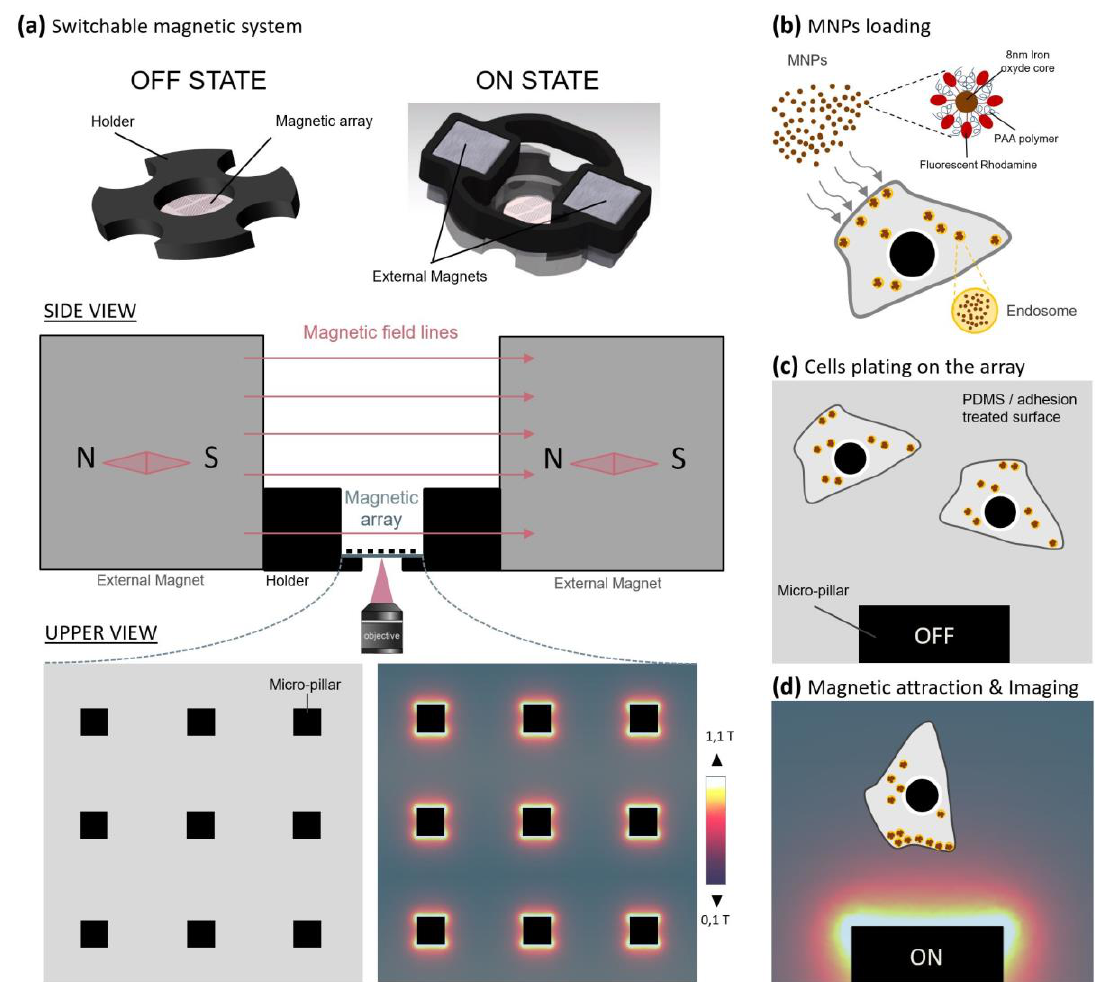
Figure 1. Parallelized magnetic manipulation on a micro-magnetic array. The micro-magnetic array consists of a matrix of 100-µm-wide soft ferromagnetic pillars. The micro-pillars can be magnetized using a homogeneous external magnetic field (ON State) or demagnetized when the field is removed (OFF State). Magnetized micro-pillars generate a high magnetic gradient up to 10 4 T/m ( a ). The micro-magnetic array was made biocompatible by coating the surface with thin PDMS layer and an adhesion molecule coating. To perform the magnetic manipulation experiment, cells were first loaded with magnetic nanoparticles (MNPs) during 18–24 h in 6-well plate using the passive endocytosis process ( b ). Loaded cells were then plated on the magnetic array until their complete adhesion without magnetic activation (OFF state) ( c ). Finally, external magnets were added in both sides of the array to activate the micro-magnetic pillars (ON state) and both transmission and fluorescence imaging were done over 18 h–72 h in a 37 °C 5% CO 2 chamber ( d ).